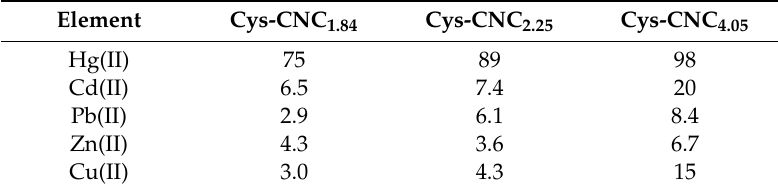
Table 3. Percentage of metal removal using various cysteamine-modified cellulose nanocrystal (Cys-CNC)